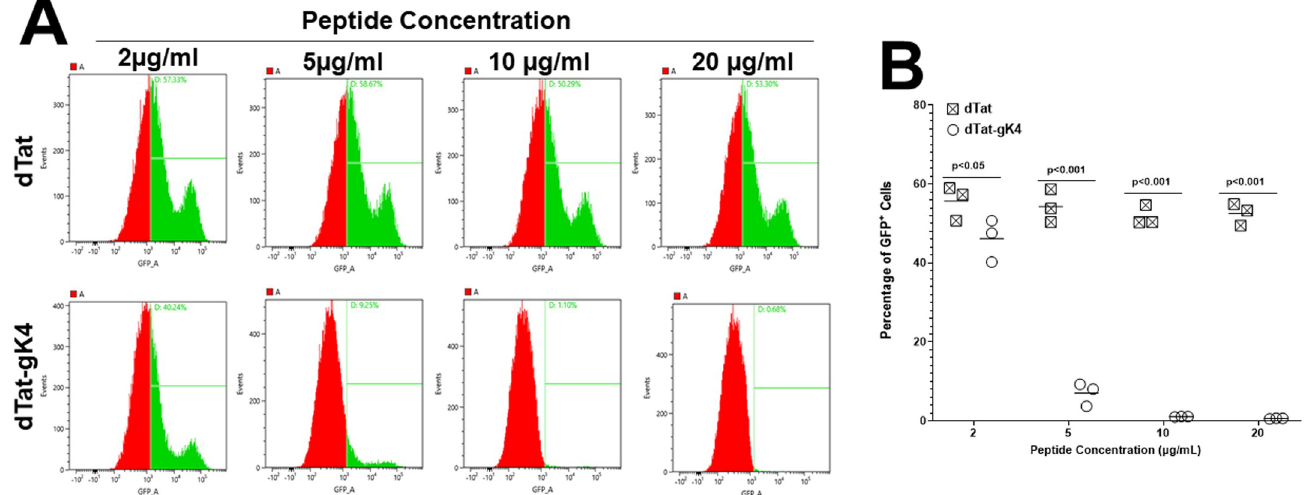
Fig 4. Analysis of infected cells in the presence of gK4 peptide. (A) Detection of HSV-GFP ± cells. Vero cells were infected with 0.1 PFU/cell of HSV-1 expressing GFP in the presence of 2, 5, 10, and 20 μ g/ml of dTat-gK4 peptide or control dTat peptide for 1 hr. After 1hr infection, the media was replaced with fresh media containing each peptide. At 24 hr PI, cells were trypsinized, fixed, and the presence of GFP + cells at each peptide concentration was determined by FACS. B) Quantitation of HSV-GFP ± cells. Percentage of GFP + cells infected as in (A) above were quantitated by FACS. Each point represents the mean ± SEM from four independent